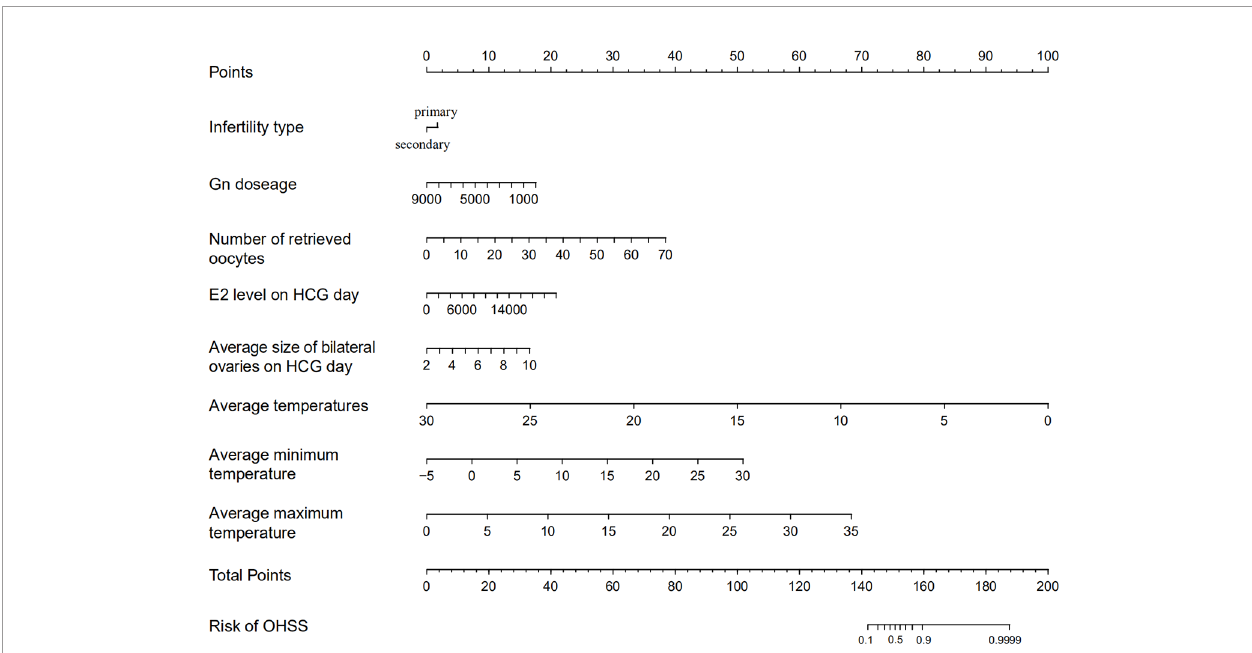
FIGURE 2 | Ovarian hyperstimulation syndrome (OHSS) risk nomogram. The scaled line to the right of each variable represents the value range of the variable, while the length of the line indicates the size of the variable ’ s contribution to the outcome event. The value of each variable corresponds to the Points at the top of the fi gure, and all the scores add up to the Total points at the bottom. The risk of OHSS occurrence is represented by the Total points corresponding to the value of Risk of OHSS at the bottom of the fi gure.